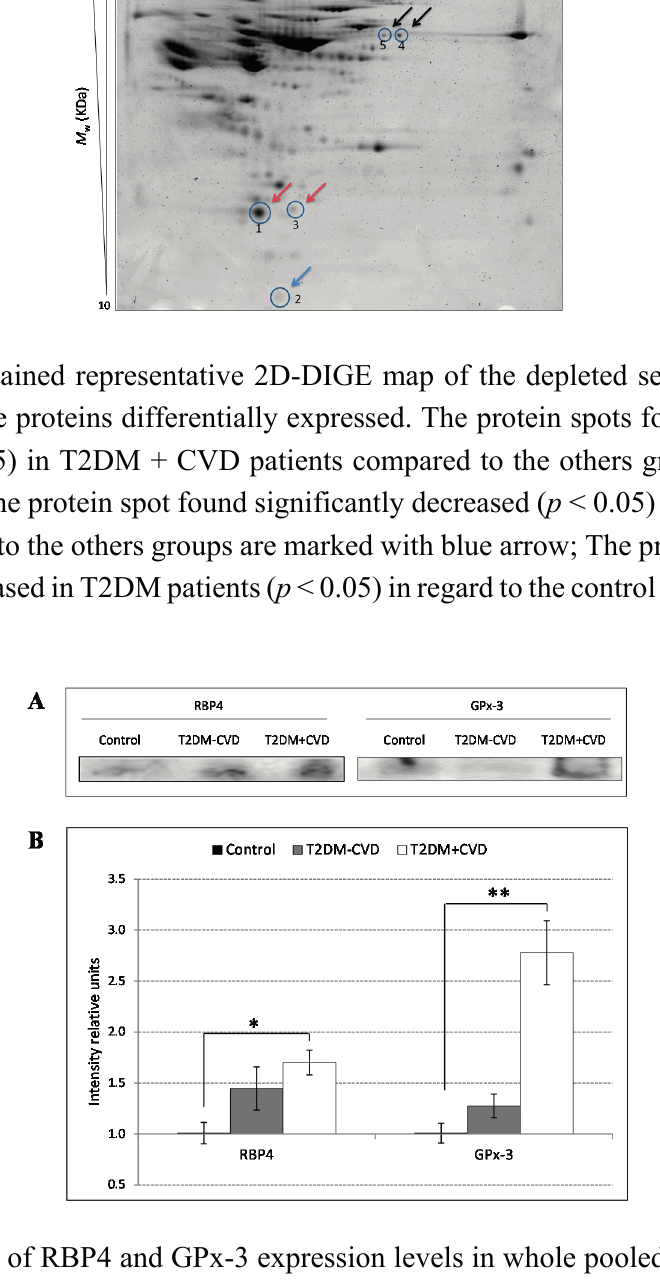
Figure 2. Analysis of RBP4 and GPx-3 expression levels in whole pooled serums from the T2DM patients with and without CVD and the control subjects in three independent experiments of five subjects per group (45 study subjects in total). ( A ) Representative western blot analysis of correspondent RBP4 and GPx-3 pattern showing an increase of RBP4 and GPx-3 in T2DM patients compared to control group; ( B ) Quantification of the protein levels by densitometry analysis of the three western blots showing a significant increase of RBP4 and GPx-3 between T2DM patients with CVD and control subjects. The gel bands were normalized to value 1 corresponding to the control and the protein expression from the T2DM patients with and without CVD is represented relative to the control group. Differences between groups were determined by the Mann-Whitney U test. * p < 0.05; ** p <